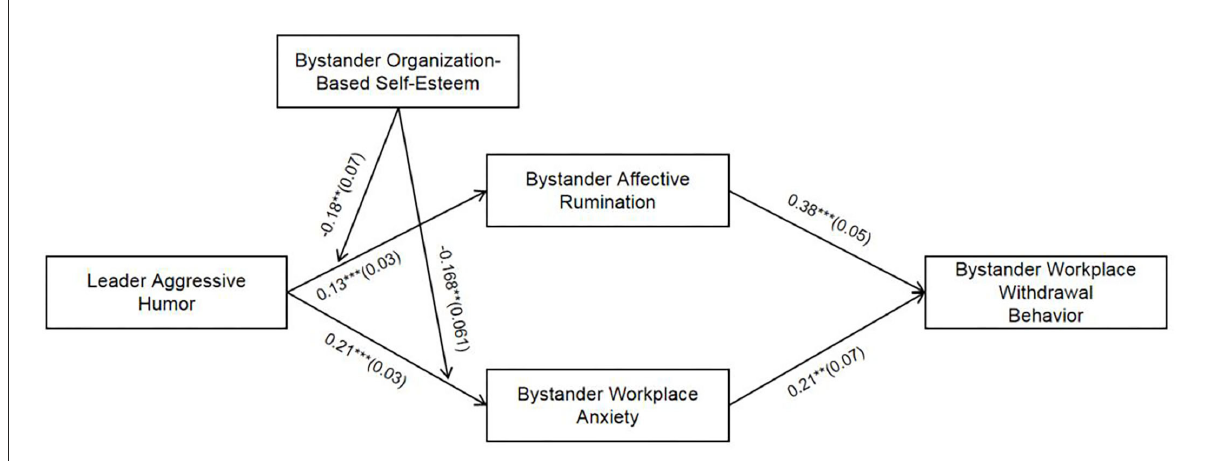
FIGURE2 Path coefficient of the structural equation. * p < 0.05; ** p < 0.01; *** p < 0.001; coefficients in the graph are standardized coefficients with standard errors in parentheses; control variables are age, gender, and education background.